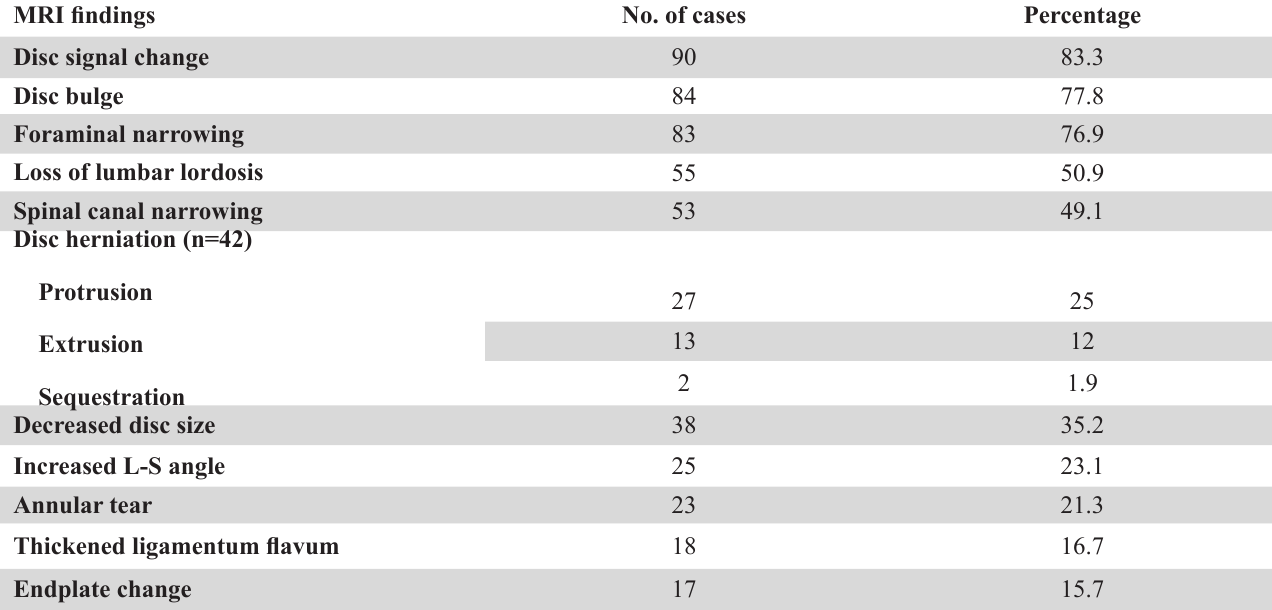
Table 1. MRI findings of LS spine in the study population (n=108)